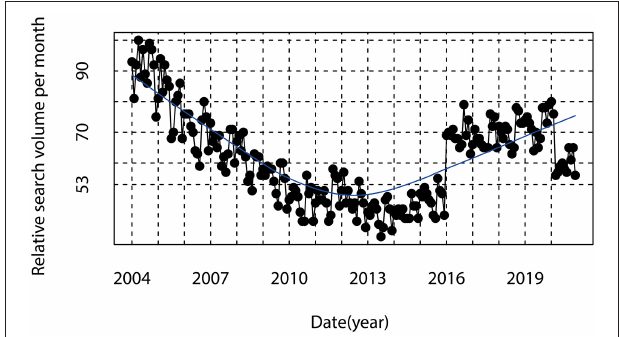
FIGURE 1 | Time series plots for the Alzheimer’s disease-related relative search volume worldwide.